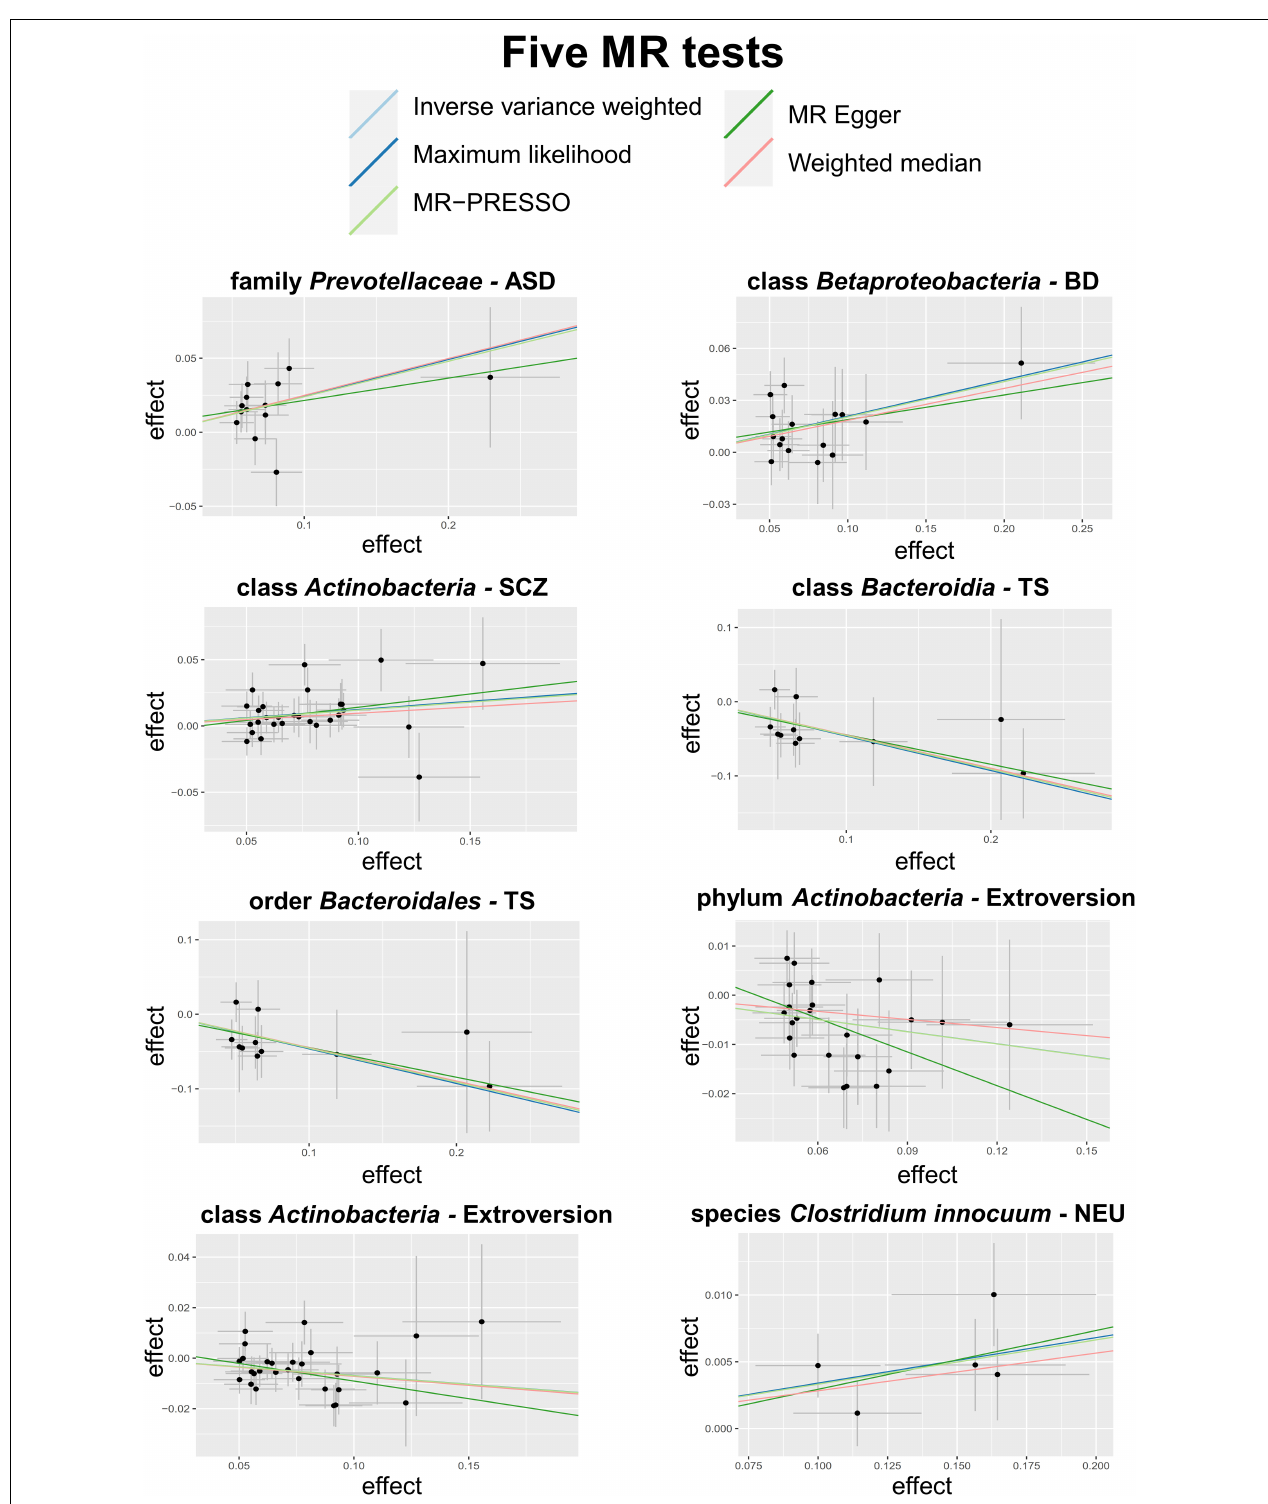
FIGURE 2 | Scatter plots of the 5 MR tests in 8 causal associations from 7 bacterial features to 6 psychiatric disorders/traits. SNP effects were plotted into lines for the inverse-variance weighted test (light blue line), MR-Egger regression (green line), weighted median estimator (red line), MR-PRESSO (light green line) and maximum likelihood estimator (blue line). The slope of the line corresponded to the causal estimation.